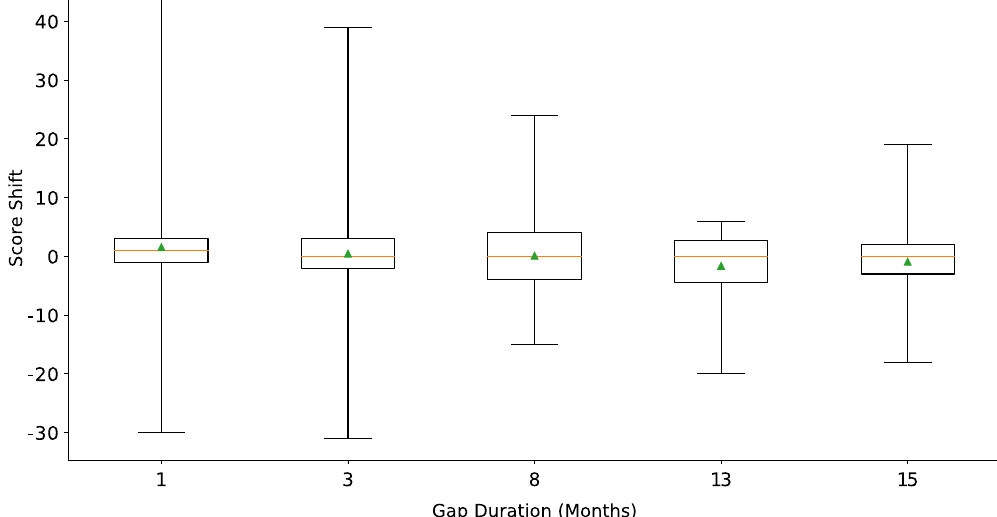
FIG. 2. Box and whisker plots of the FMCE raw score shift for each of the five gap duration in the dataset. The center line for each boxplot represents the median shift, the triangular points represent the mean and the box denotes the interquartile range (meaning 50% of responses fall within this range), and the whiskers show the max and min shift value (with a max possible shift of 47 points in either direction). All duration lengths had a median score shift of 0 pts except the 1 month duration, which had a median score shift of 1 pt. The number of students in each group is given in Table